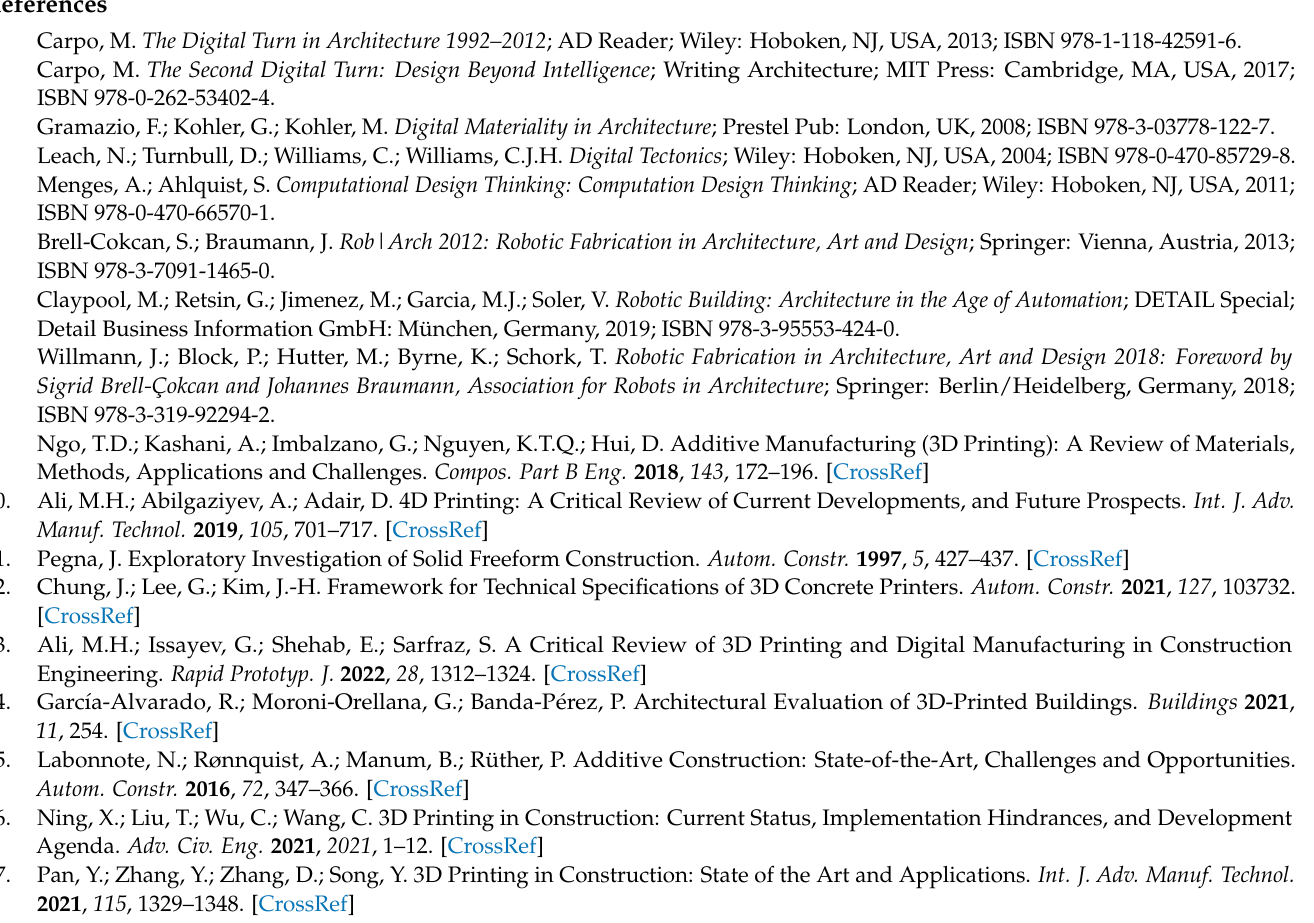
Figure A1. Publication rate of filtered articles on 3DP in architecture.